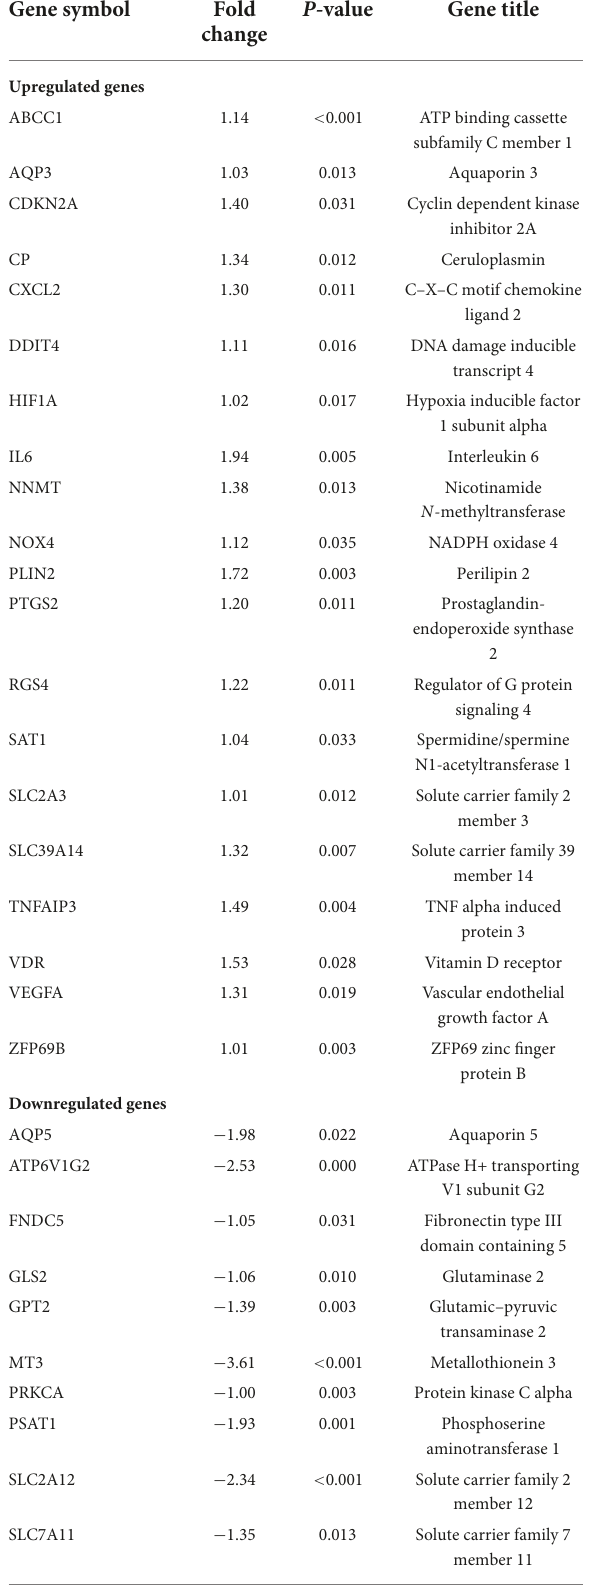
TABLE 1 Ferroptosis differentially expressed genes (DEGs) of intracranial aneurysm (IA).